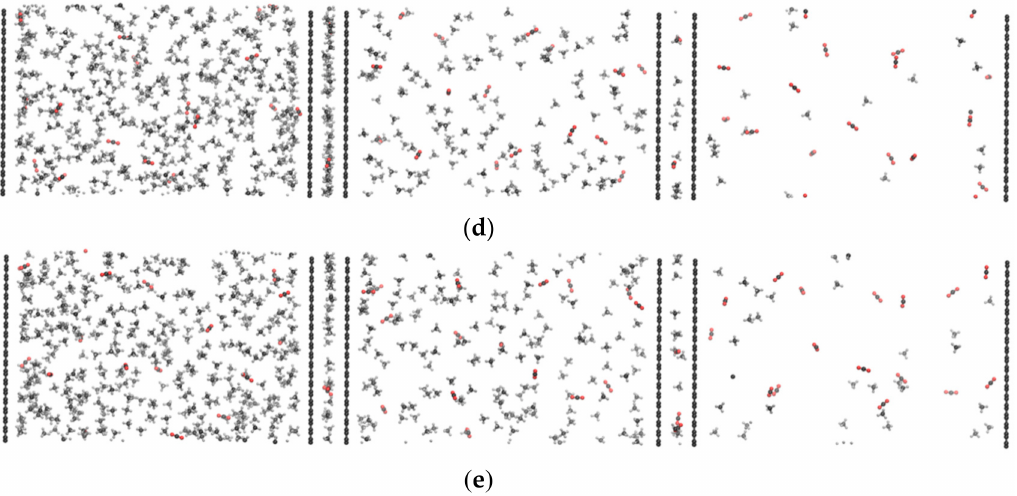
Figure 2. Snapshots from the time evolution of the inline configuration (W = 0) with the interlayer spacing of 8 Å within 4ns; from top to bottom: ( a ) 0 ns, ( b ) 1 ns, ( c ) 2 ns, ( d ) 3 ns, and ( e ) 4